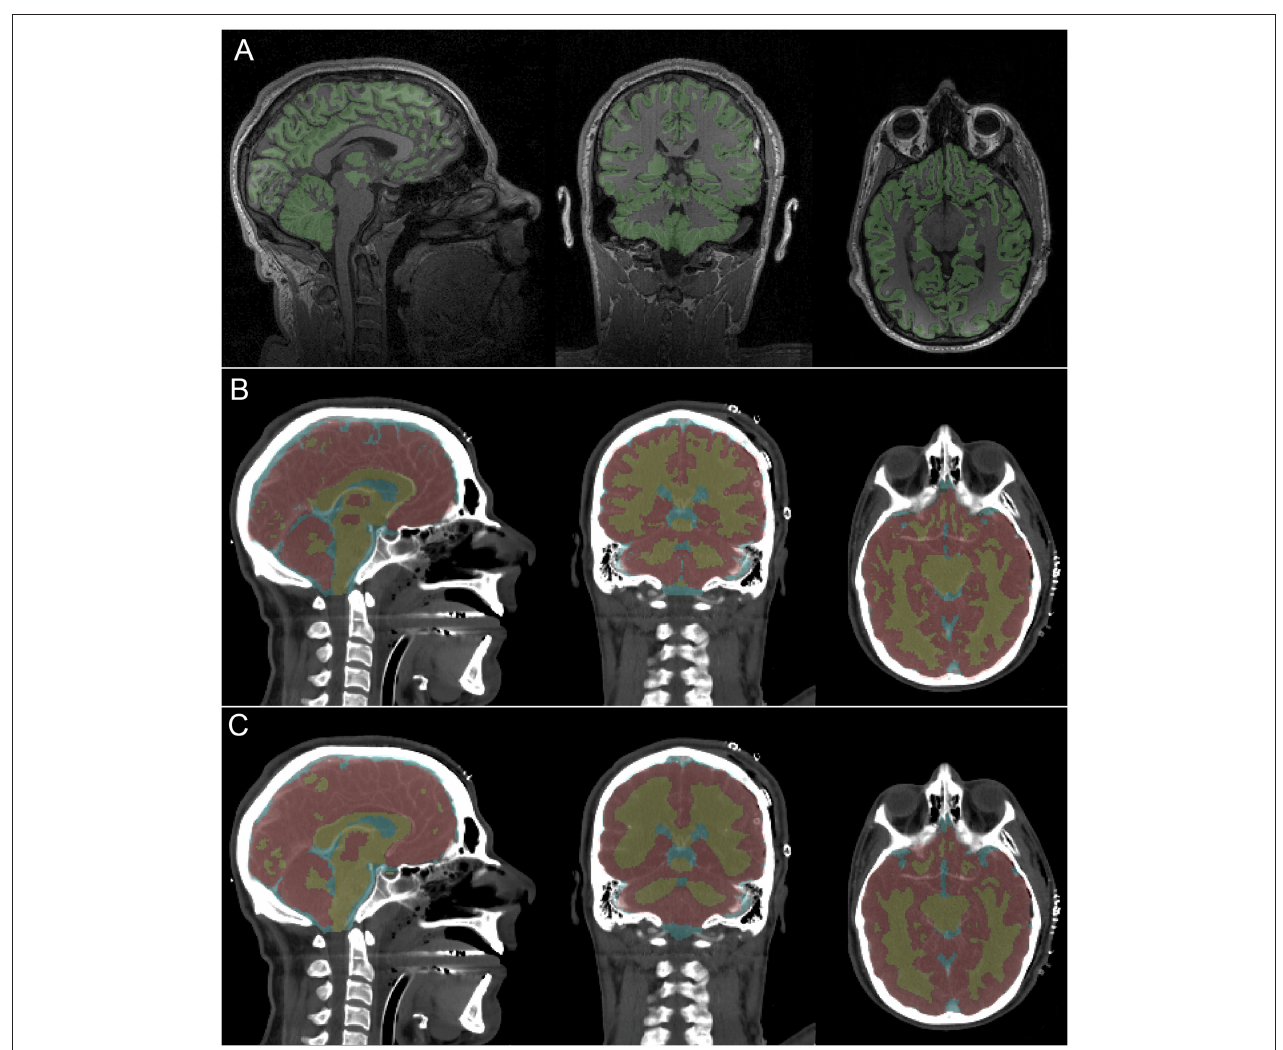
FIGURE 1 | MRI and CT segmentations and their corresponding imaging slices for a representative subject. Colored voxel label maps are translucent to ease inspection of the underlying neuroanatomy. (A) T 1 -weighted MRI slices show GM (green). The WM is left uncolored to facilitate identifying occasional differences between the true GM/WM boundary and the FreeSurfer-identified boundary. (B) CT slices display labeled GM (red), WM (yellow) and CSF (light blue) based on segmentation at the original CT volume resolution (1 × 1 × 1.25mm). (C) Like (B) , based on segmentation at a down-sampled CT volume resolution (1 × 1 ×